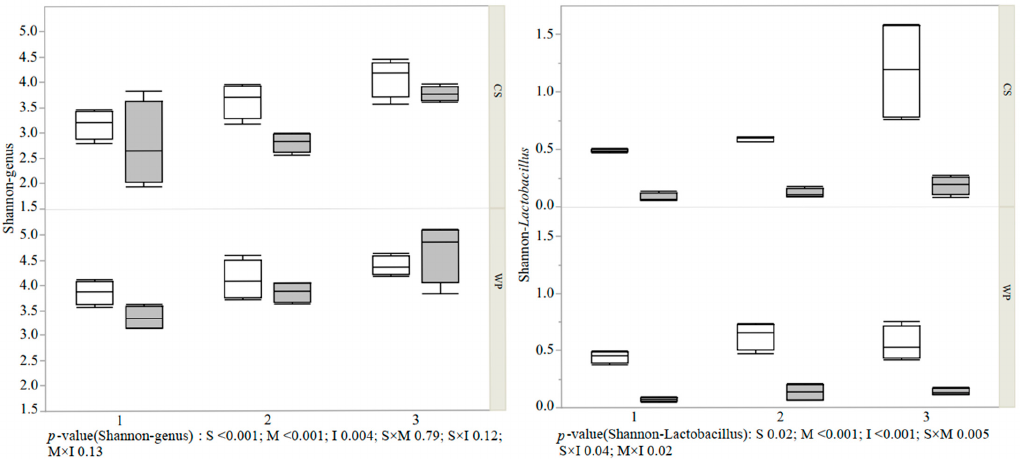
Figure 5. Effects of substrate, ensiling time, and inoculation of Lactobacillus plantarum on the Shannon index of bacterial diversity at the genus level and of the Lactobacillus genus diversity at OTU level (n = 4). Substrates are shown in panels. CS, sweet corn stover; WP, sweet corn whole plant. Sampling time points (months after ensiling) are scattered along the x axis. Inoculation with Lacto- bacillus plantarum is indicated with gray filling in the box plots. p values for the following effects are provided in legends below the graph: M, Months after ensiling; S, substrate; I, inoculation; S × M; interaction between substrate and month; S × I; interaction between substrate and inoculation; M × I; interaction between month and inoculation. Inoculation resulted in higher abundance of genus Lactobacillus in WP silage ( p = 0.01) but not in CS silage ( p = 0.63; interaction S × I, p < 0.001; Figure 6). Inoculation increased the abundance of Lactobacillus at the end of first month after ensiling ( p = 0.014), and did not affect it at the second and third month of ensilage ( p ≥ 0.11; interaction M × I, p = 0.09). Pseudomonas increased after ensiling and was at its highest abundance at the end of the third month after ensiling in CS silage ( p < 0.001), whilst it reached its highest abundance in month 2 after ensiling in WP silage ( p = 0.03; interaction S × M, p = 0.005). Inoculation